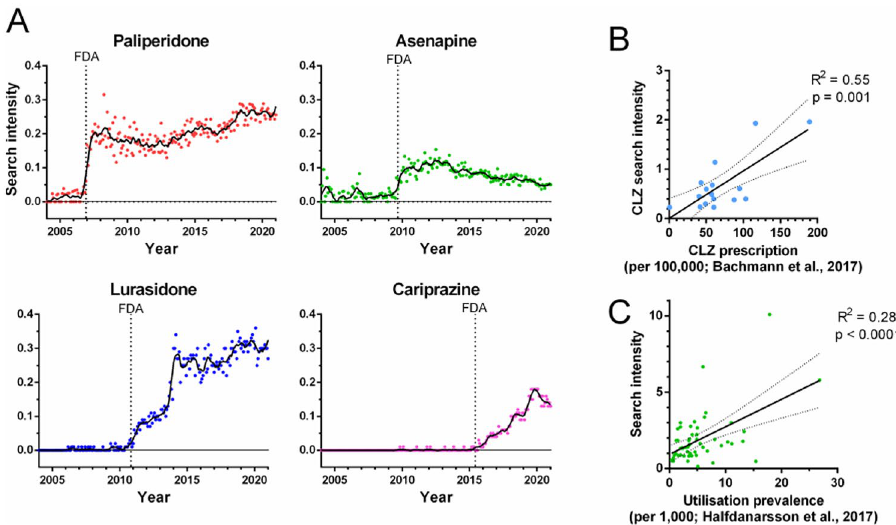
Figure 1. Evaluation of antipsychotic drug (APD) search intensities in relation to approval and country-wise prescription. Search intensities are normalized to the maximal intensity of haloperidol, in 2004–2020. Data from “low search intensity regions” are included. ( A ) Worldwide search intensities for recently approved APDs (FDA approval date; dotted line) are paliperidone (Dec 2006), asenapine (Aug 2009), lurasidone (Oct 2010), and cariprazine (May 2015). Smooth polynomials of order 2 were adapted to 6 adjacent points (black traces). ( B ) Clozapine search intensities in relation to clozapine prescription for 16 countries in 2014, as reported by Bachmann et al. 16 (linear regression, R 2 = 0.55 and p = 0.001). For USA, the reported public and private insurance groups were averaged 16 . Clozapine search intensities were not available for Iceland. ( C ) APD search intensities in relation to prescription of the five most common APDs in 13 countries in year 2014 15,16 (linear regression, R 2 = 0.28 and p < 0.0001). Levomepromazine and prochlorperazine were not included because of the exclusion represent 95% CI. CLZ, clozapine. See Supplementary Tables S1, S2, and S3 for underlying search intensities and respective publications for prescription data 15,16